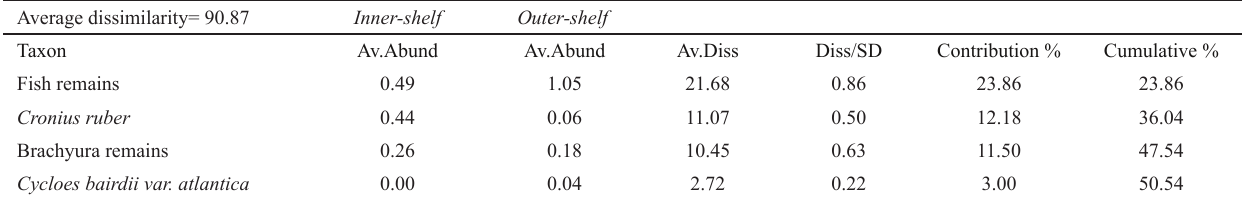
Tab. 4. Results from two-way crossed dissimilarity of percent (SIMPER) analyses for significant Habitat effects. Species contributions that summed cumulatively to >75% are shown. Av.Abund = Average abundance, Av.Diss = Average dissimilarity, Diss/SD = Dissimilarity Standart